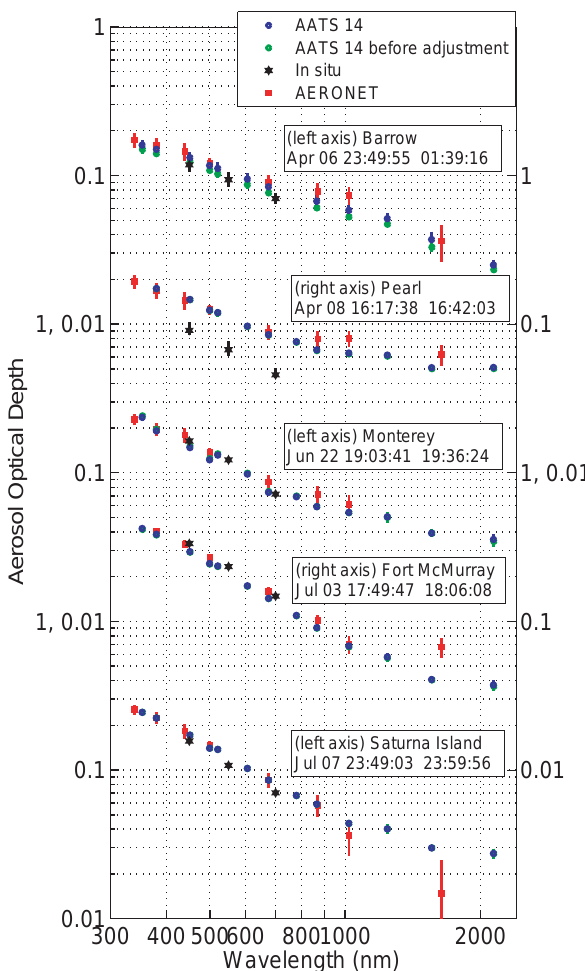
Fig. 6. Full-column AODs observed with airborne (AATS-14, Neph+PSAP) and ground-based (AERONET) instruments over Barrow, Pearl, Monterey, Fort McMurray and Saturna